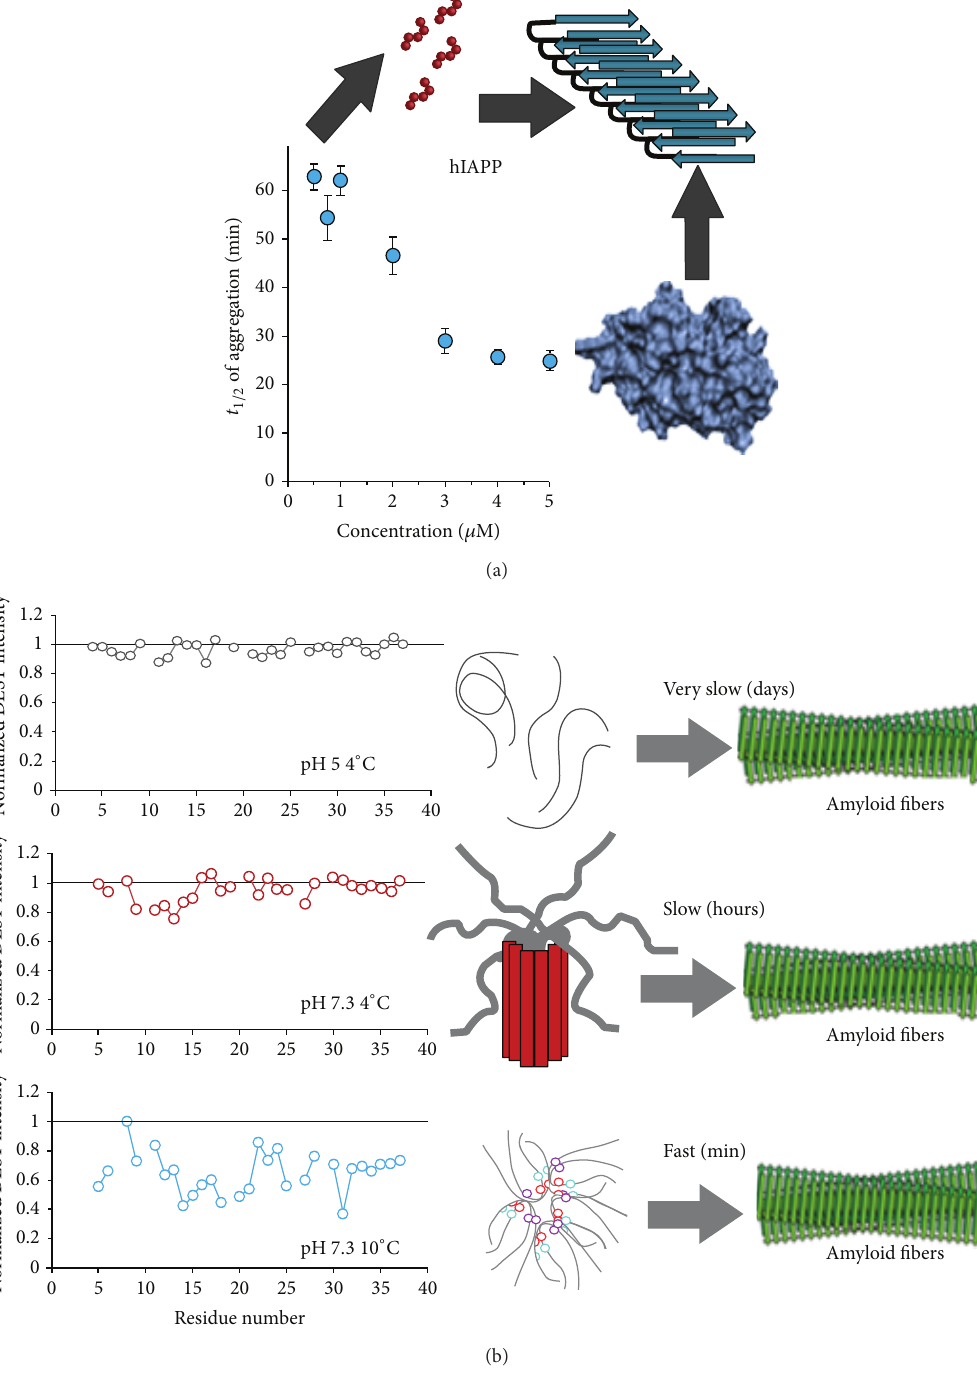
Figure2:DependenceofIAPPself-associationonsampleconditions.(a)IAPPaggregationisstronglydependentontheformationofmicelles occurring at specific critical micellar concentrations. (b) Mapping of the self-association of hIAPP as a function of pH and temperature. (Top) The micelle is not formed when H18 is ionized and no self-association is observed below pH 6. (Middle) At neutral pH, but below a critical temperature for micelle formation (4 ∘ C), small oligomers form which predominantly interact with the N-terminal helix (residues 7–16). (Bottom) Above the temperature for micelle formation (10 ∘ C), self-association is found throughout the peptide but particularly in the central region (residues 12–21). Adapted from